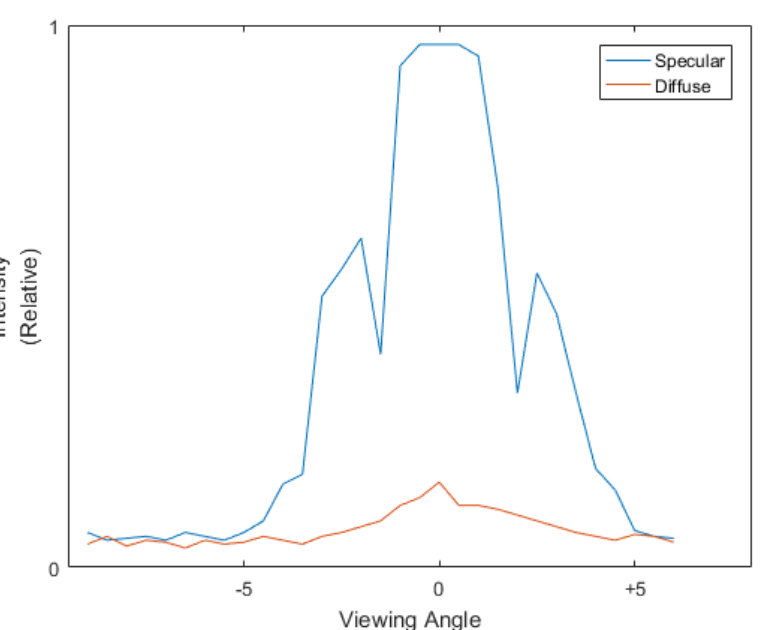
Figure 2. The BRDF-distribution measurement result of surfaces with different reflection charac- teristics.